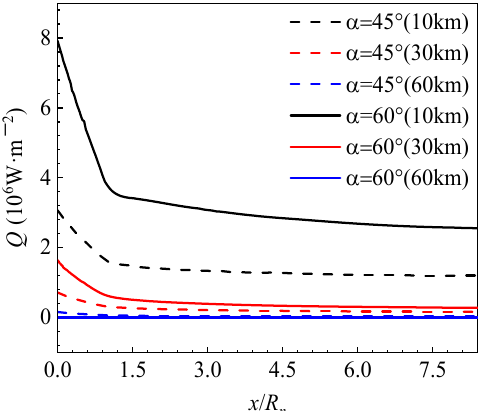
Figure 11. Heat flux profiles of blunt body surface in representative cases.